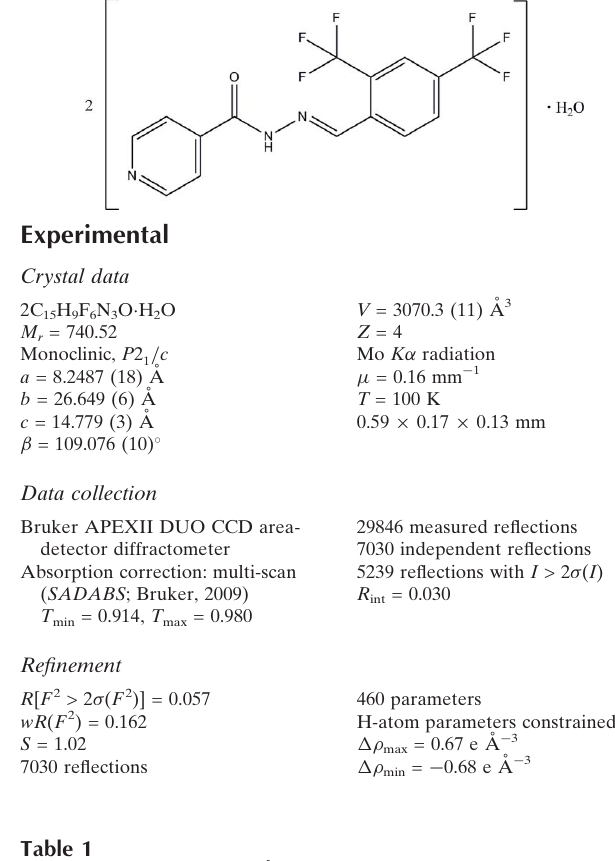
Hydrogen-bond geometry (A˚ , (cid:3)